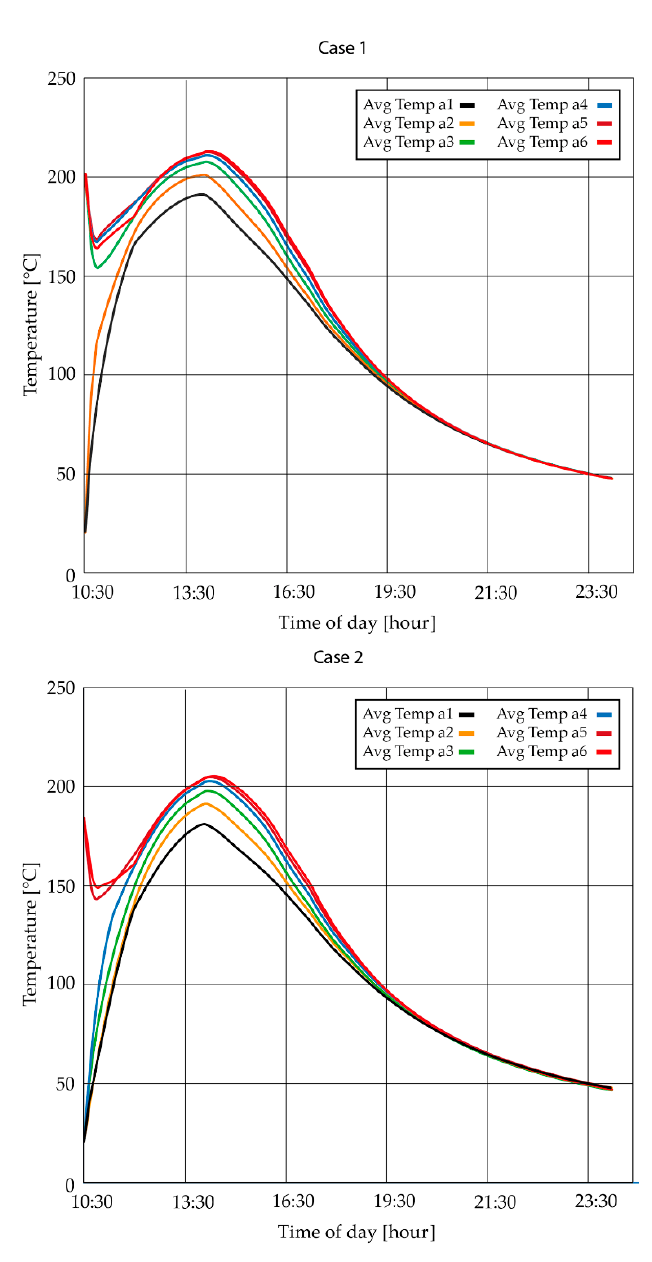
Figure 14. The course of the temperature of heat accumulators for Case 1 and Case 2.